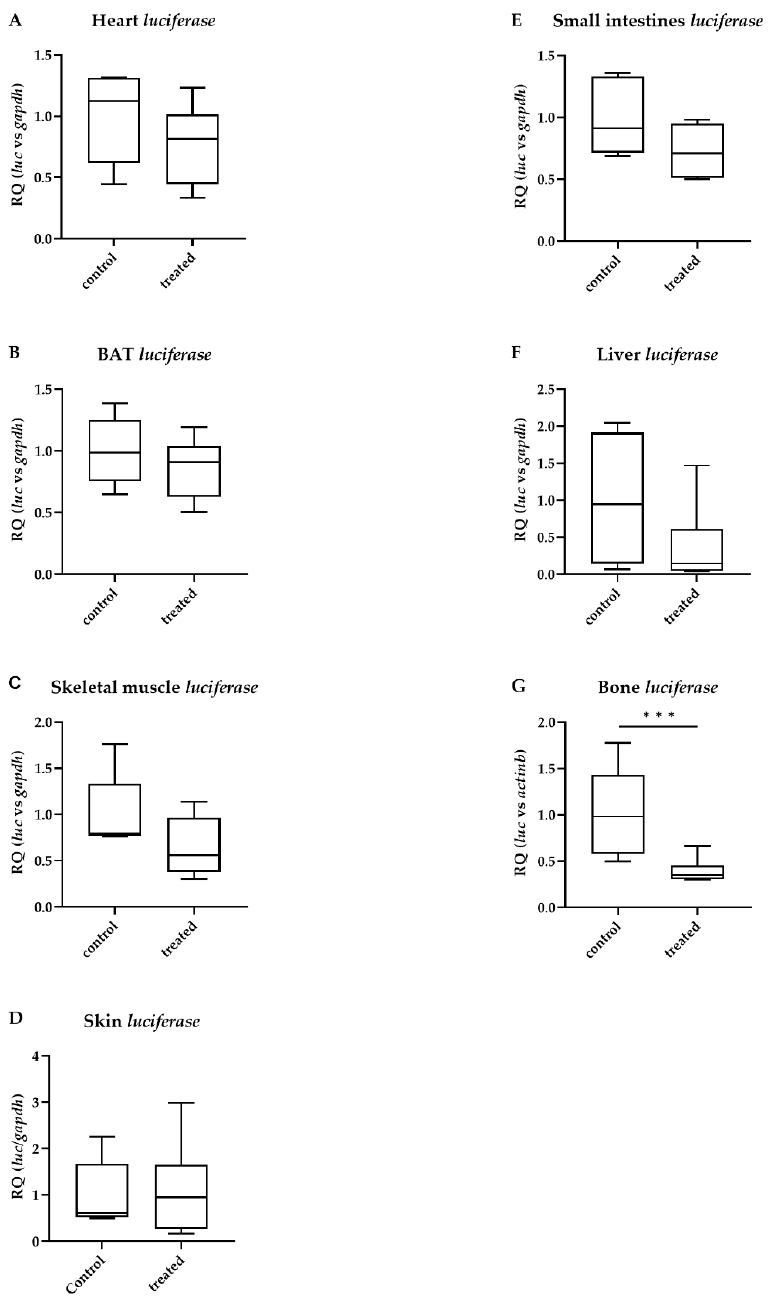
Figure 1. Peripheral thyroid hormone action after tetrabromobisphenol A (TBBPA) treatment. Thy- roid hormone action quantified with luciferase mRNA levels in male THAI mice after six days of oral administration of 150 mg/bwkg/day of TBBPA in corn oil containing 2% Et-OH; ( A ) heart; ( B ) brown adipose tissue; ( C ) skeletal muscle; ( D ) skin; ( E ) small intestine; ( F ) liver; ( G ) bone. n = 4–6 mice/group; figure shows Tukey Box Plots, α = 0.05; ***: p <